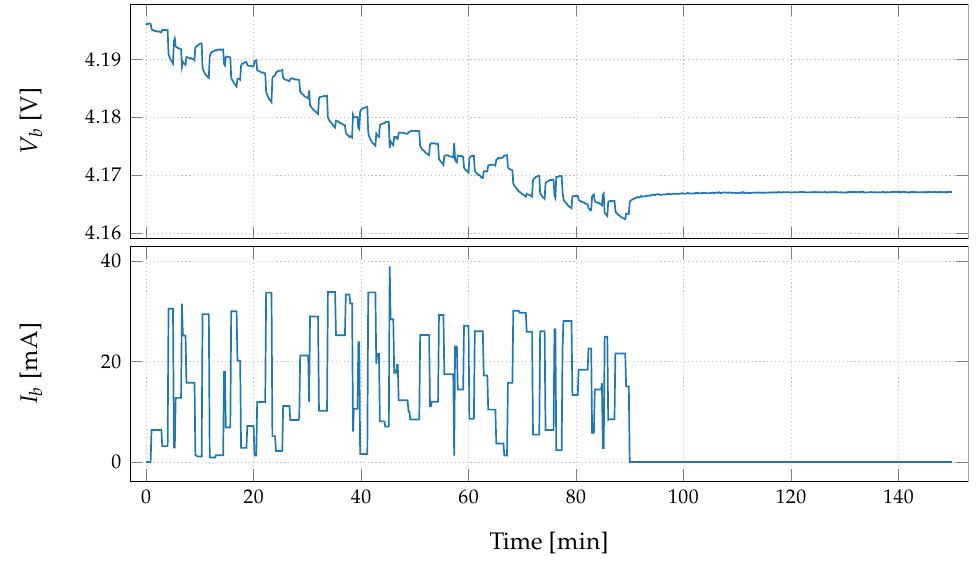
Figure 14. Measured voltage and current during a random load